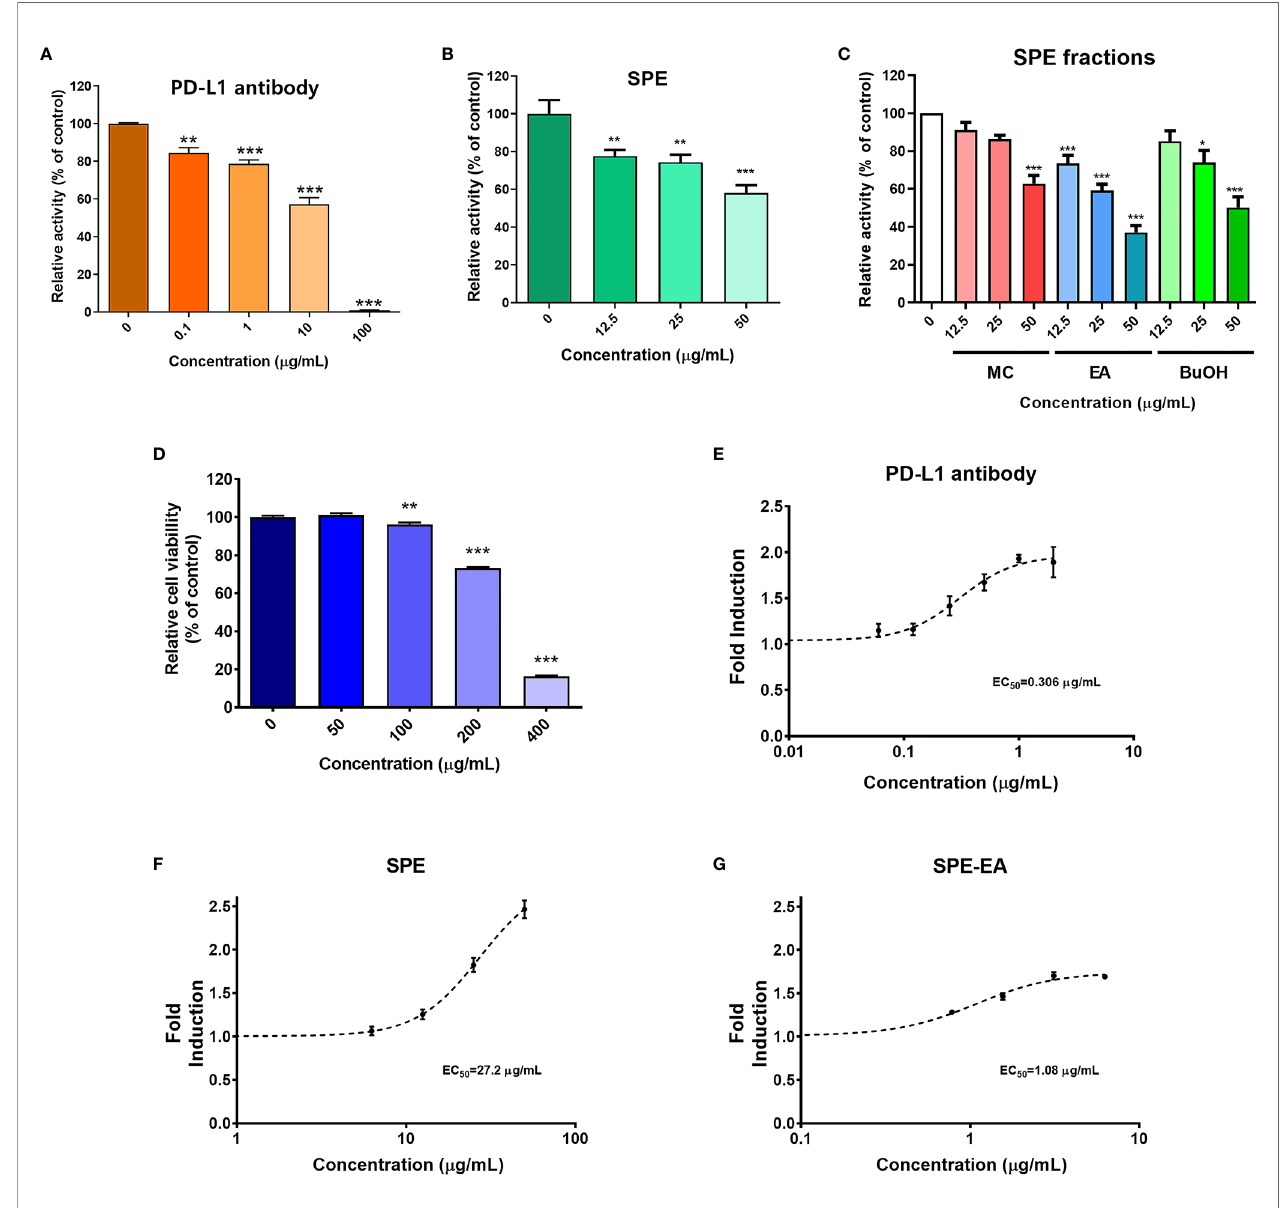
FIGURE 1 | PD-1/PD-L1 interaction blockadeby Salviaplebeia R. Br.ethanol extract (SPE).Competitive ELISA was performed using PD-1/PD-L1 inhibitor ELISA- screening assay with the indicated concentrationsof PD-L1-blocking antibody, SPE, and SPE fractions. (A) Inhibition ofthe PD-1/PD-L1interaction byPD-L1-blocking antibody, (B) SPE, and (C) SPEfractions (methylene chloride[MC], ethyl acetate [EA], and n-butanol [BuOH]). Cytotoxicity and T-cellactivation bySPE and its ethyl acetate (EA) fraction in vitro . (D) The viabilities ofPD-L1aAPC/CHO-K1and PD-1 effector cells were assessed using the Cell Counting Kit-8 (CCK) assay after treatment with the indicatedconcentrationsof SPE for 24 h. (E – G) A PD-1/PD-L1blockadebioassay was performed to assess the inhibitoryactivities of PD-L1-blocking antibody, SPE, and SPE-EA. PD-L1aAPC/CHO-K1cells were platedand incubatedat 37°Cfor 20 h prior to the addition of PD-1 effector cells and increasing concentrationsof (E) PD-L1- blockingantibody, (F) SPE, or (G) SPE-EA. Bar graph(mean ± standarderror ofthe mean) statistics were determined with the dataof three experiments, using one-way ANOVA with Tukey ’ s post-hoc test; ***P < 0.001, **P < 0.01, *P < 0.05, n.s, not signi fi cant, compared with the